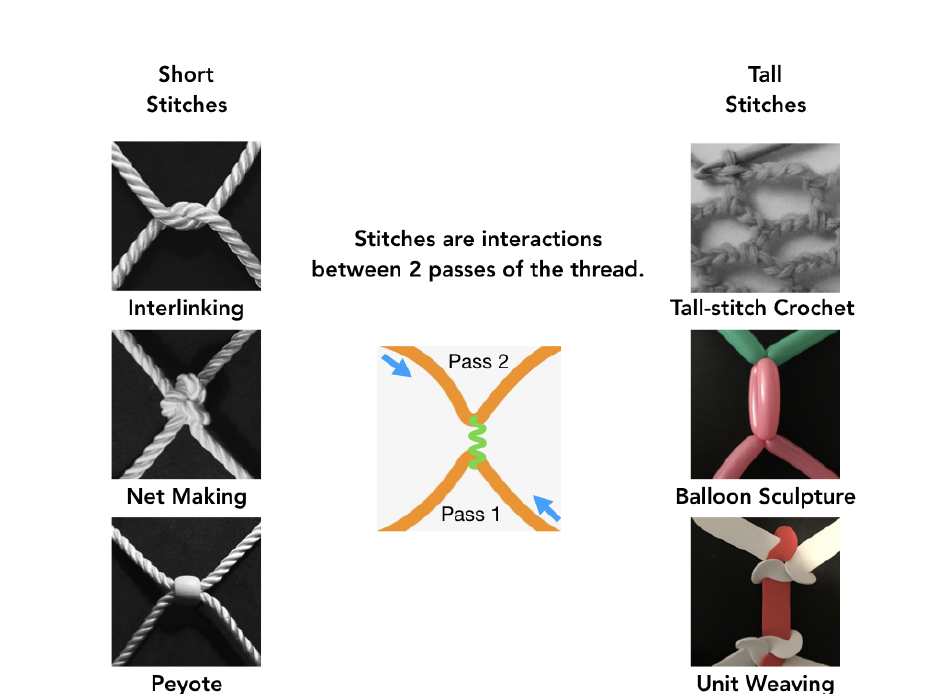
Figure 9. Examples of fabric techniques that can be abstracted as an A-trail on the basket